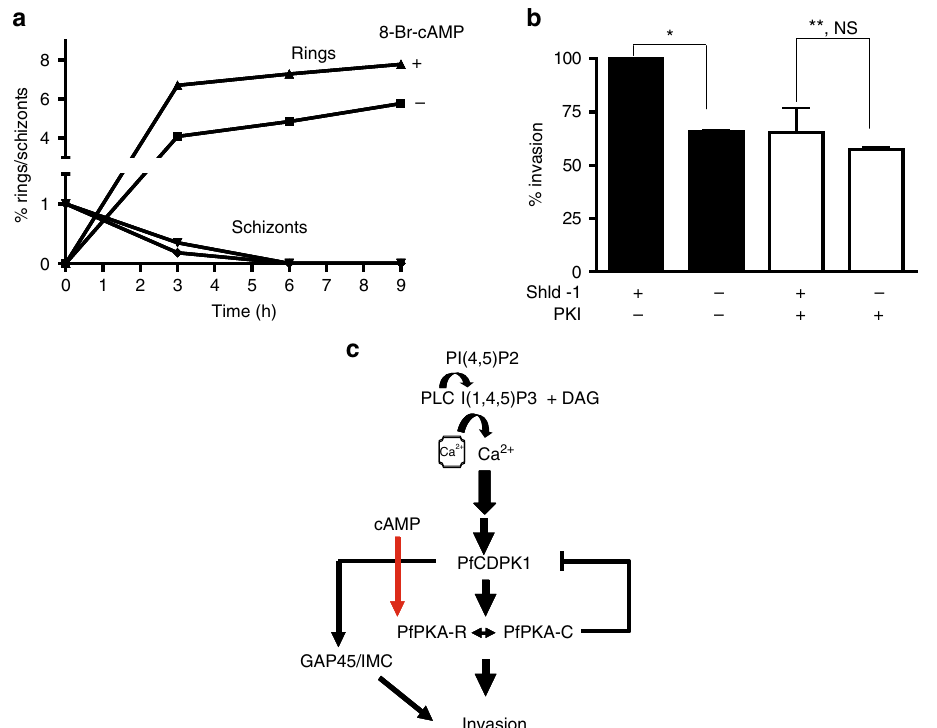
Fig. 6 Regulation of invasion by PfCDPK1 and PfPKA. a The invasion of PKA-R-GFP schizonts in the absence (squares) or presence (triangles) of 8Br-cAMP was assessed by counting the number of rings and schizonts on Giemsa smears after indicated time as described above. A representative of three independent experiments is shown. b Shld-1 was withdrawn from the parasites and invasion assays were performed using schizonts as described above. In one set of experiments PKI was added for 3 h before addition of fresh RBCs for invasion. The number of rings formed were counted from Giemsa stained thin blood smears, which re fl ected successful invasion. Data represents % invasion with respect to Shld-1 treated parasites (100%) (Mean ± s.e.m., n = 2 *, ANOVA, p < 0.05, ** p > NS). c Model of PfCDPK1 mediated signaling in malaria parasite: PLC-mediated calcium release results in the activation